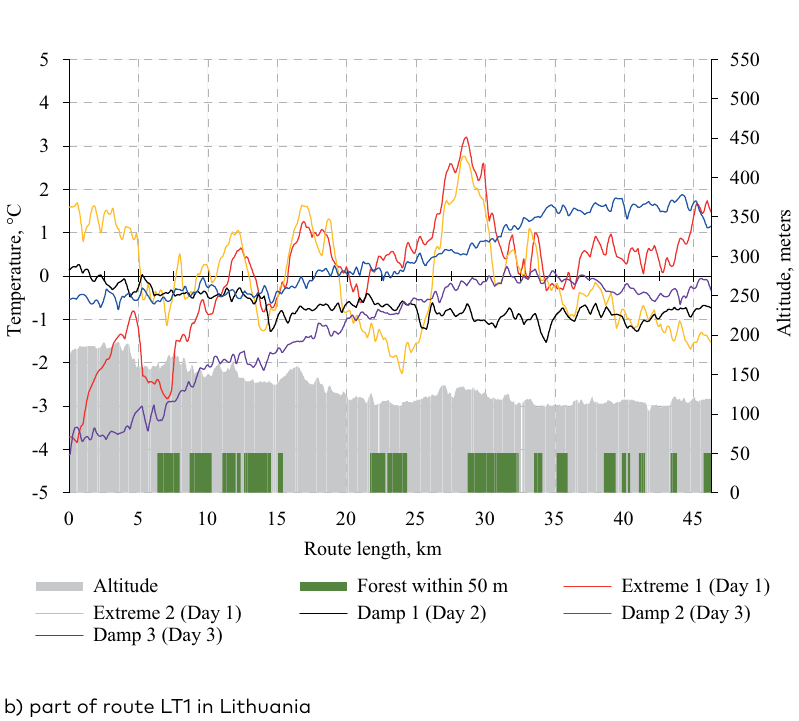
Figure 3. The temperature difference between the road surface and